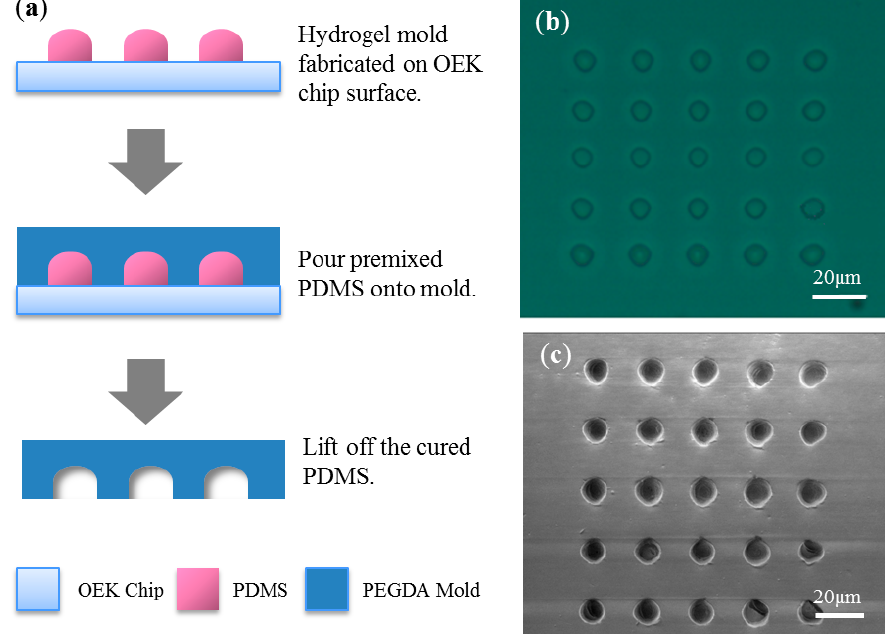
Figure 4. Illustration of the PDMS microcavity array fabrication process using a PEGDA mold fabricated by the OEK-based process. ( a ) Process flow schematic of the PDMS microcavity array fabrication. ( b ) Optical microscope image of a 5 × 5 PEGDA hydrogel micropillar array. Each micropillar was approximately 10 µm in diameter and approximately 5 µm in height. Optical pattern projection time is 60 s, apply voltage is AC 10 V pp , (the equivalent electric field value is 0.2 V pp /µm), frequency is 10 kHz. ( c ) eSEM image of the micron-scale cavities molded from the PEGDA hydrogel micropillar array. Each microcavity was approximately 10 µm in diameter and approximately 5 µm in depth.